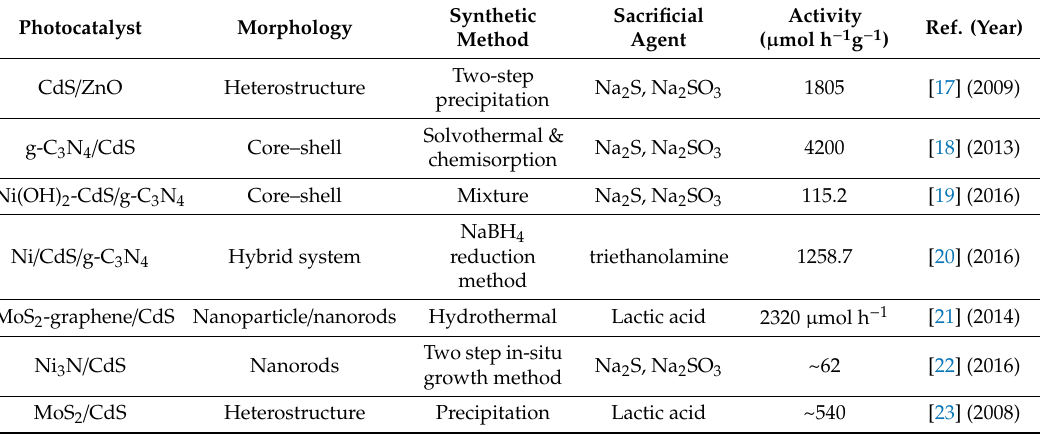
Table 1. Photocatalytic performances of CdS-based photocatalysts.